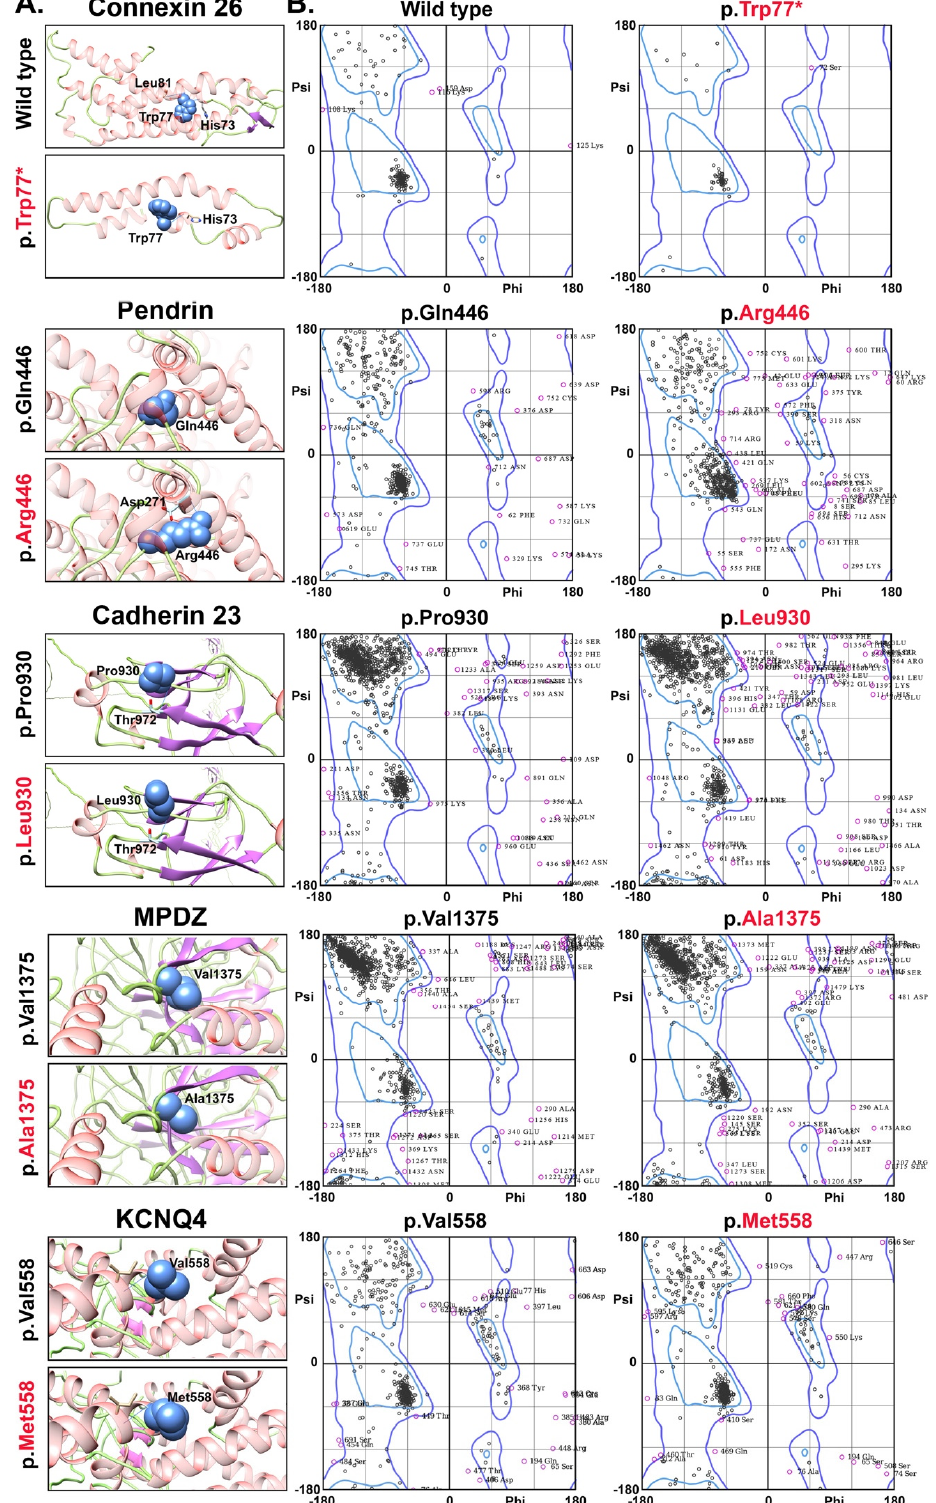
Figure 2. Hearing loss proteins 3D structures (close ups) and Ramachandran plots. ( A ) Protein secondary structure is labeled in following colors: Helix, pink; strand, purple and coils in green color. Concerned residues (shown in spheres) and hydrogen bonding pattern are represented in blue color. However, residues involved in hydrogen bonding with concerned residues are shown in stick form and colored by heteroatom. ( B ) Ramachandran plots are showing residues distribution for both wild type and mutant protein sequences side by